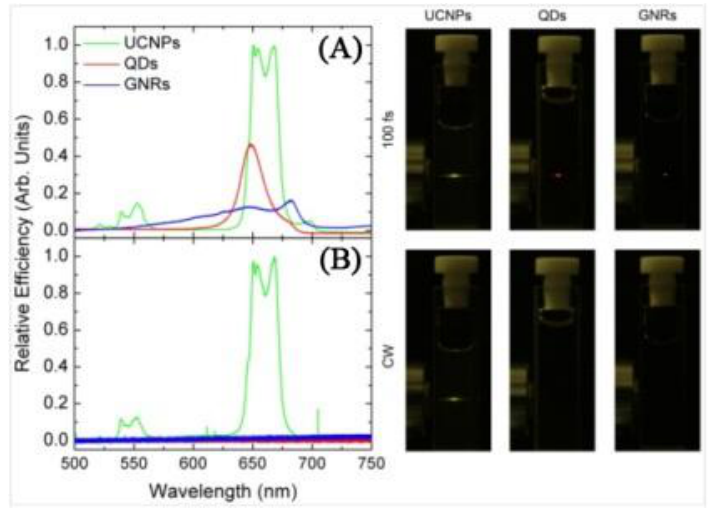
Figure 3. Left Side. ( A ) Multiphoton relative luminescence signal generated by the QD, GNR, and UCNP solution as obtained under fs laser excitation at 800, 830 and 980 nm, respectively. Pump intensity was 1 MW/cm 2 ; ( B ) Multiphoton relative luminescence signal generated by the QD, GNR, and UCNP solution as obtained under cw laser excitation at 800, 830 and 980 nm, respectively. Pump intensity was 1 MW/cm 2 . Right Side: Photos corresponding to the naked eye observations of the fluorescent samples. The pump intensity was kept the same in both cases (CW and 100 fs excitation) ([53], reproduced by permission of The Optical Society of